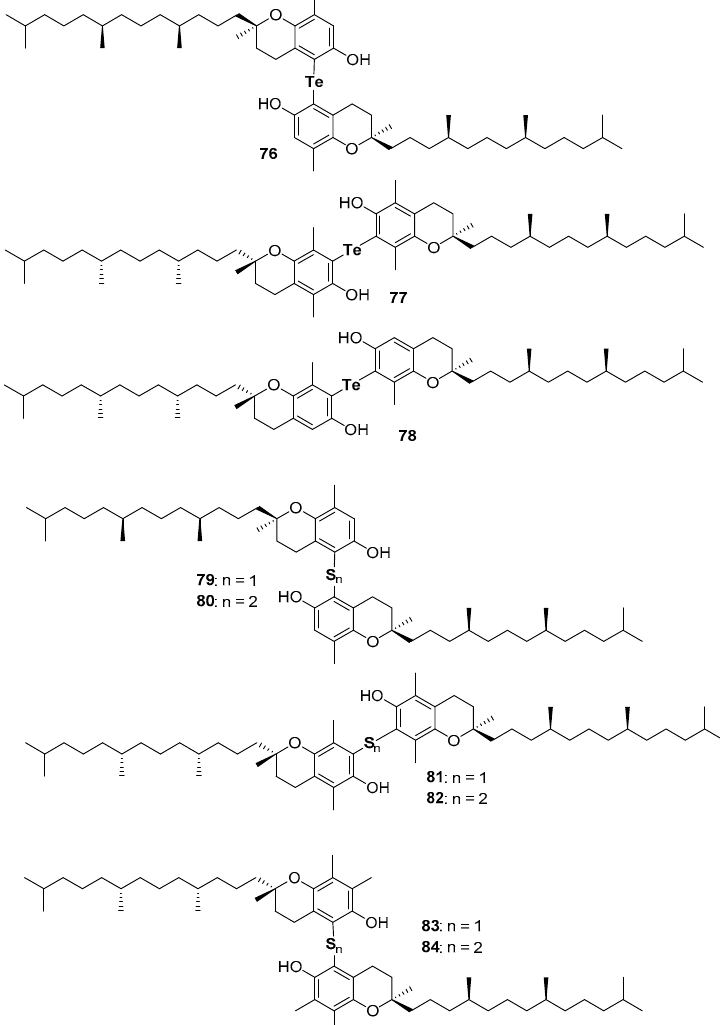
Figure 17. Chalcogens containing ditocopherols prepared so far.